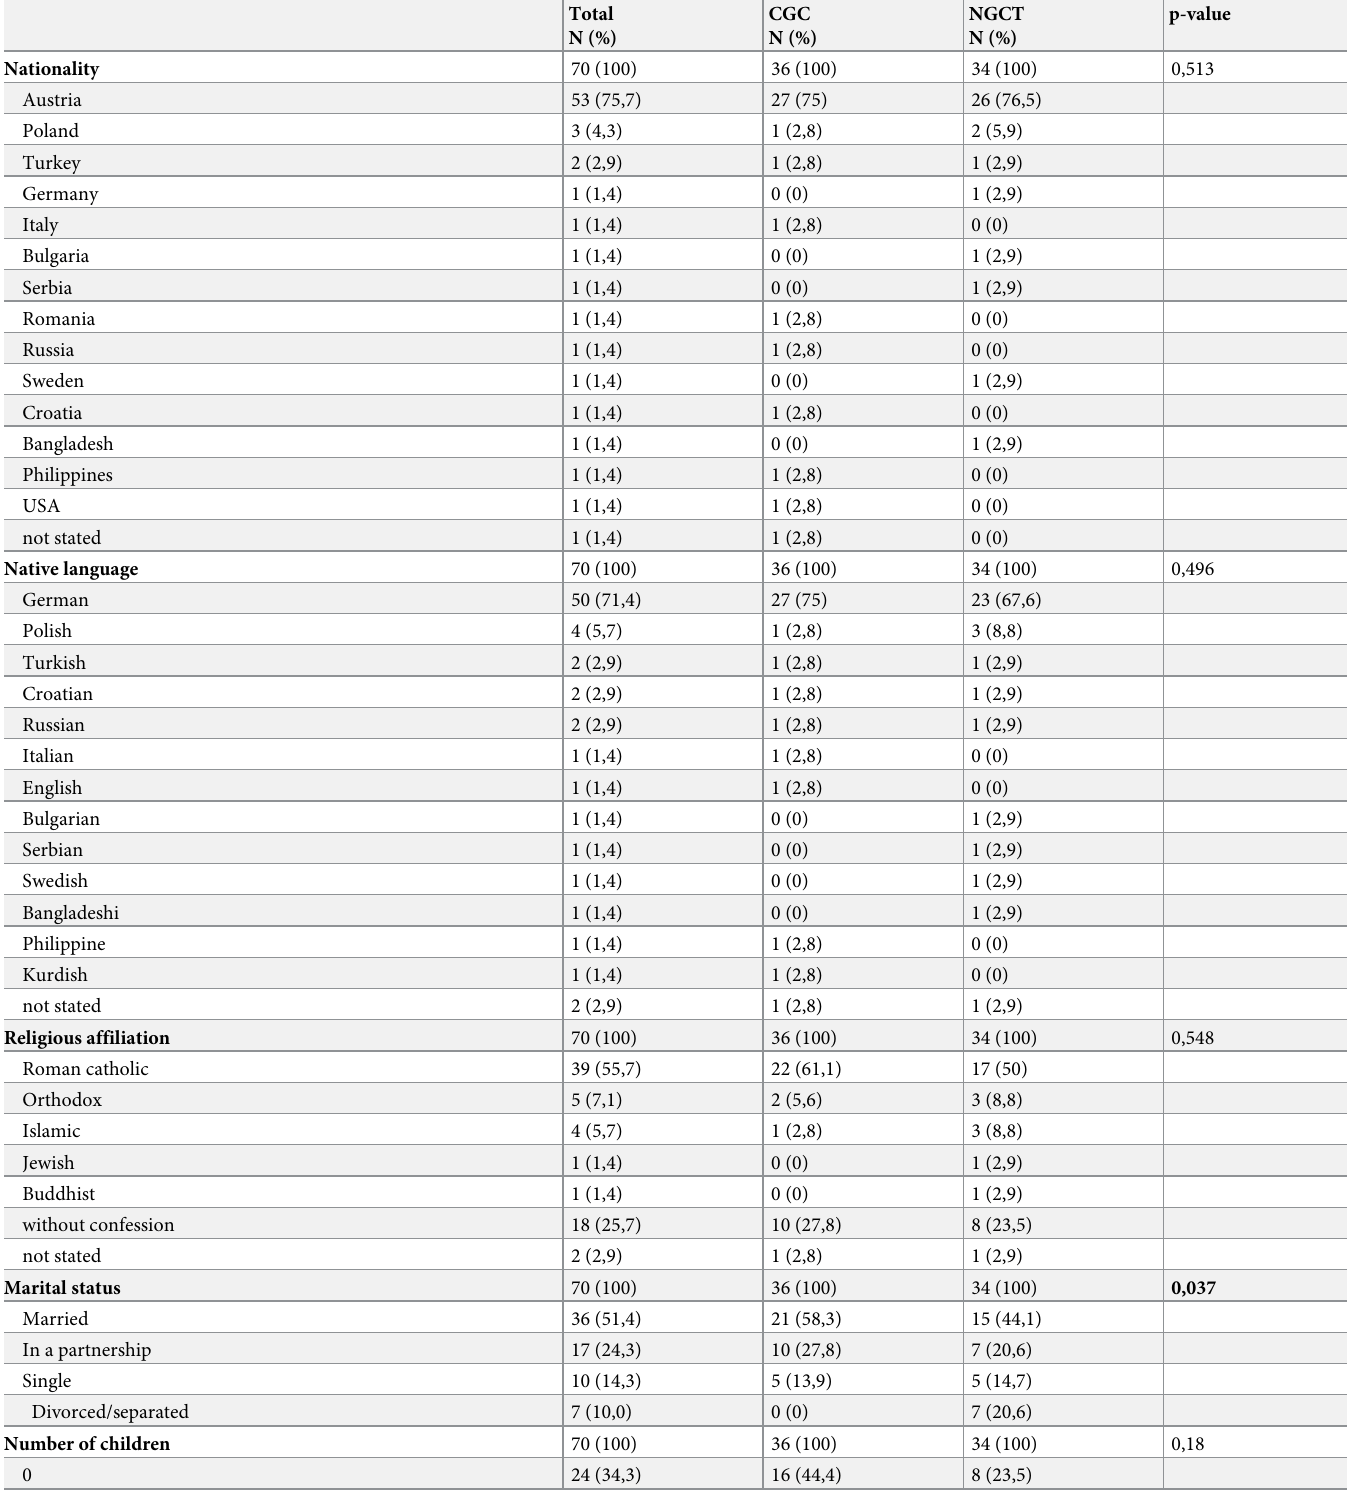
Table 1. Socio-demographic distribution of clients in both study